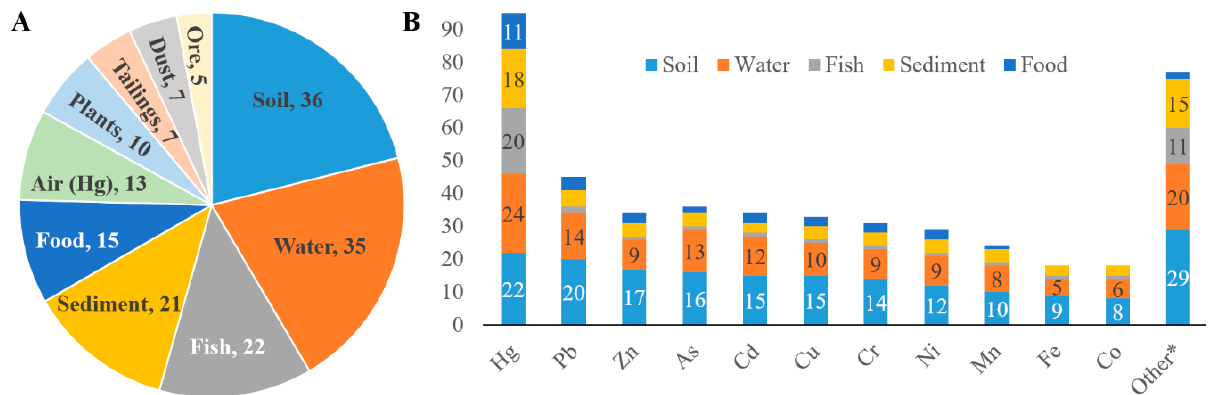
Figure 6. Profile of investigated environmental samples and pollutants. Numbers are frequency of reporting articles. Panel